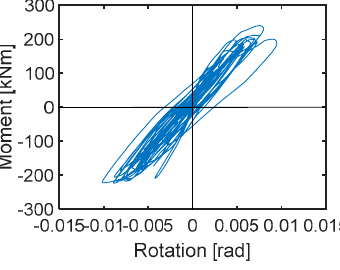
Figure 11. Bending moment-rotation response of C1 ground storey column belonging to A5 alignment around its strong flexural axis.